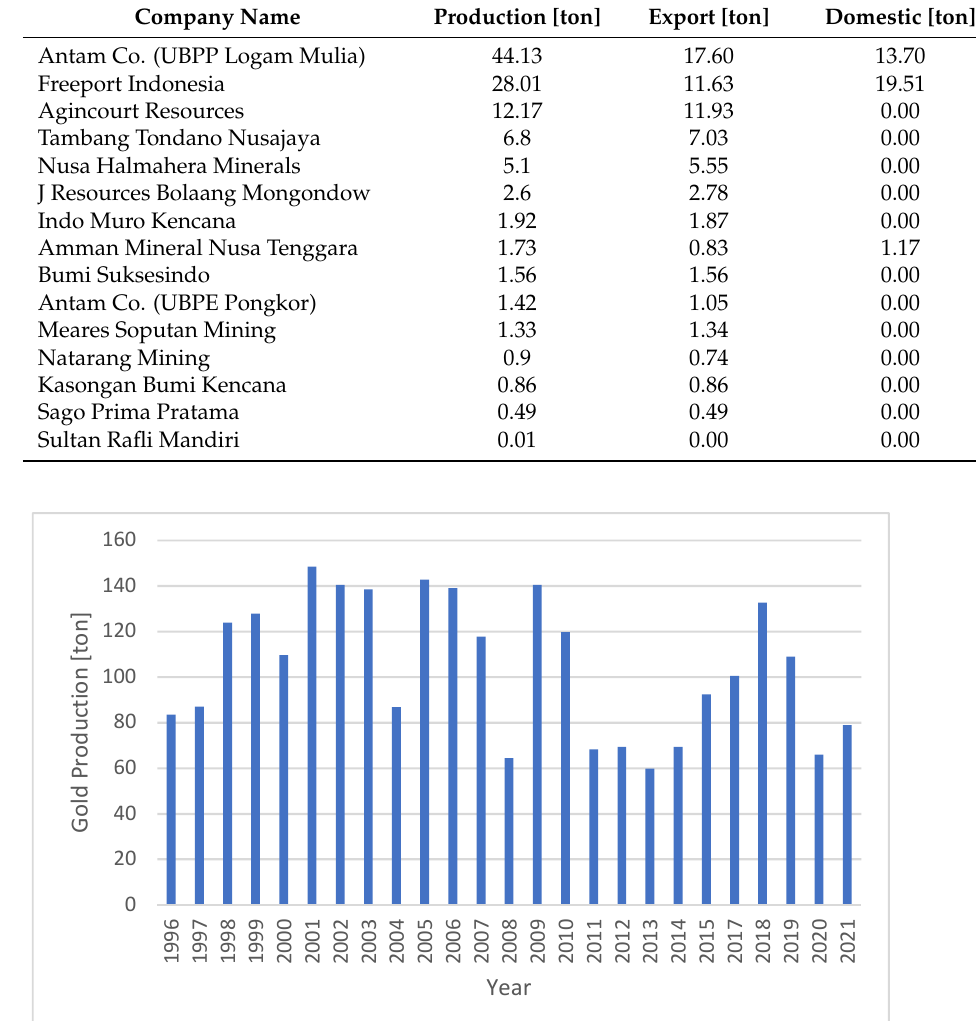
Table 2. Top 15 Gold Companies.